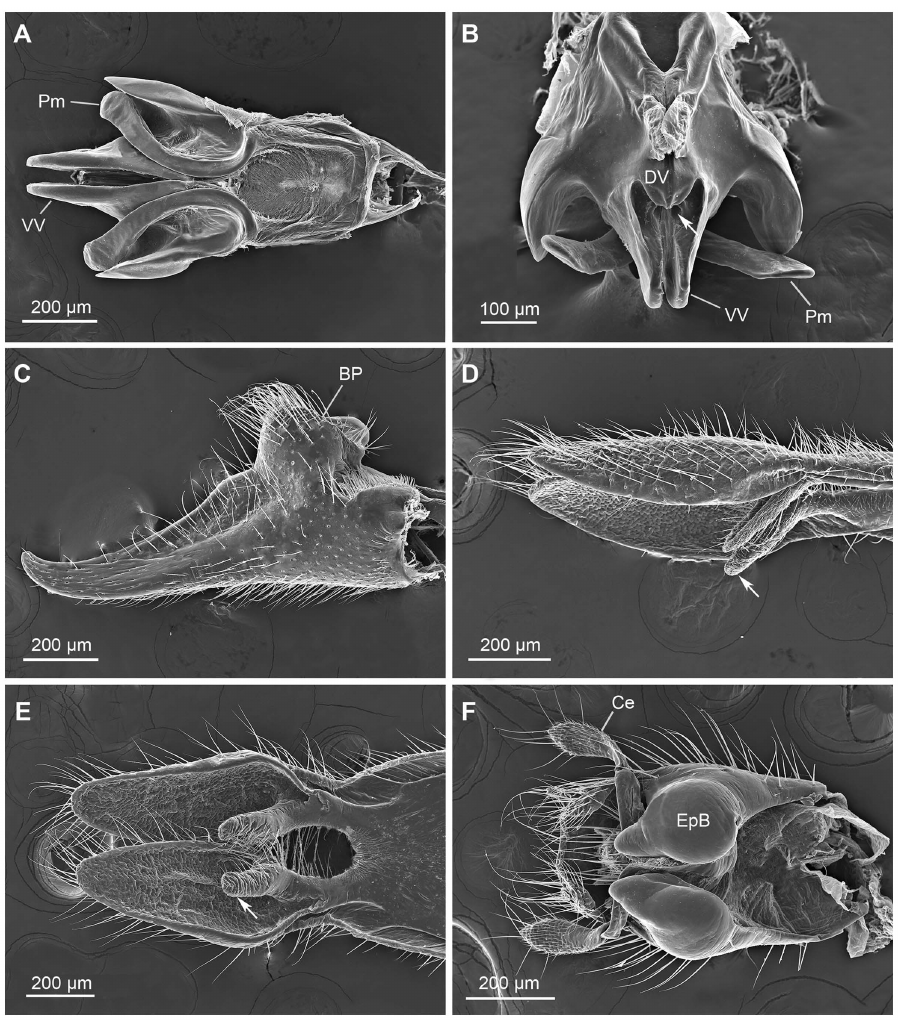
Figure 6. Male genitalic structures of N.longiprocessa . (A) Valved penis and parameres, ventral view. (B) Same, caudodorsal view, arrow showing the phallotreme. (C) Left gonostylus, ventral view. (D) Hypovalves, lateral view, arrow showing the hypandrial process. (E) Same, dorsal view, arrow showing the hypandrial process. (F) Apical part of the epandrium in ventral view, showing the epandrial bulb. BP, basal process; Ce, cercus; DV, dorsal valve of penis; EpB, epandrial bulb; Pm, paramere; VV, ventral valve of penis.